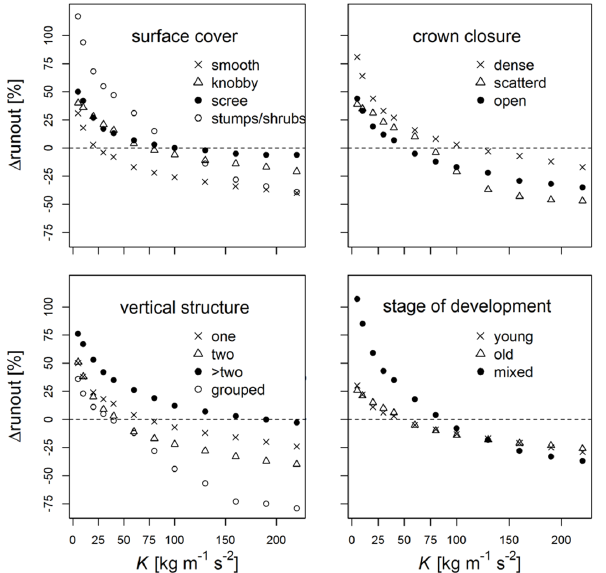
Figure 5. Mean values of 1 runout for each applied K value calcu- lated separately for the corresponding categories of four forest vari- ables. The dashed line corresponds to 1 runout = 0 indicating the potential mean optimal K value for each category of the respective forest variable.